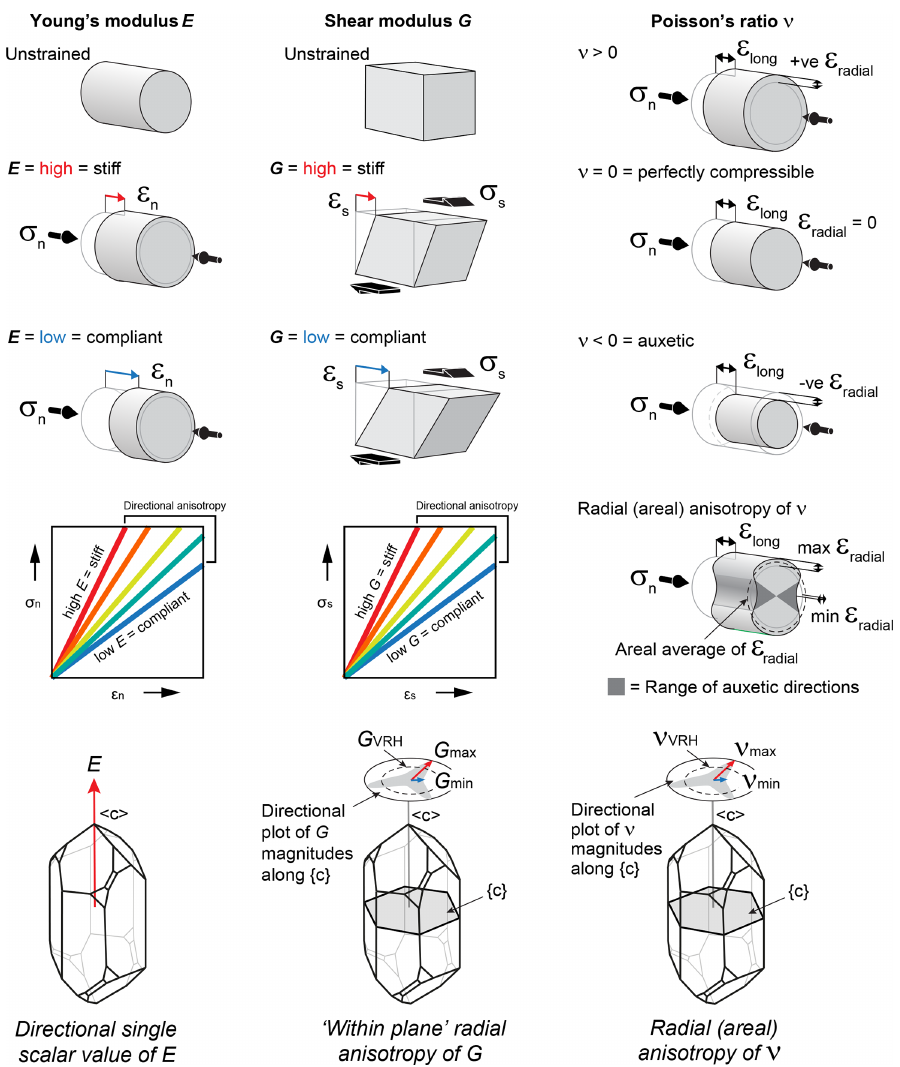
Figure 3. Schematic diagrams to illustrate the definitions of Young’s modulus, Poisson’s ratio and shear modulus in a 3D crystallographic reference frame, using α -quartz (trigonal) as an